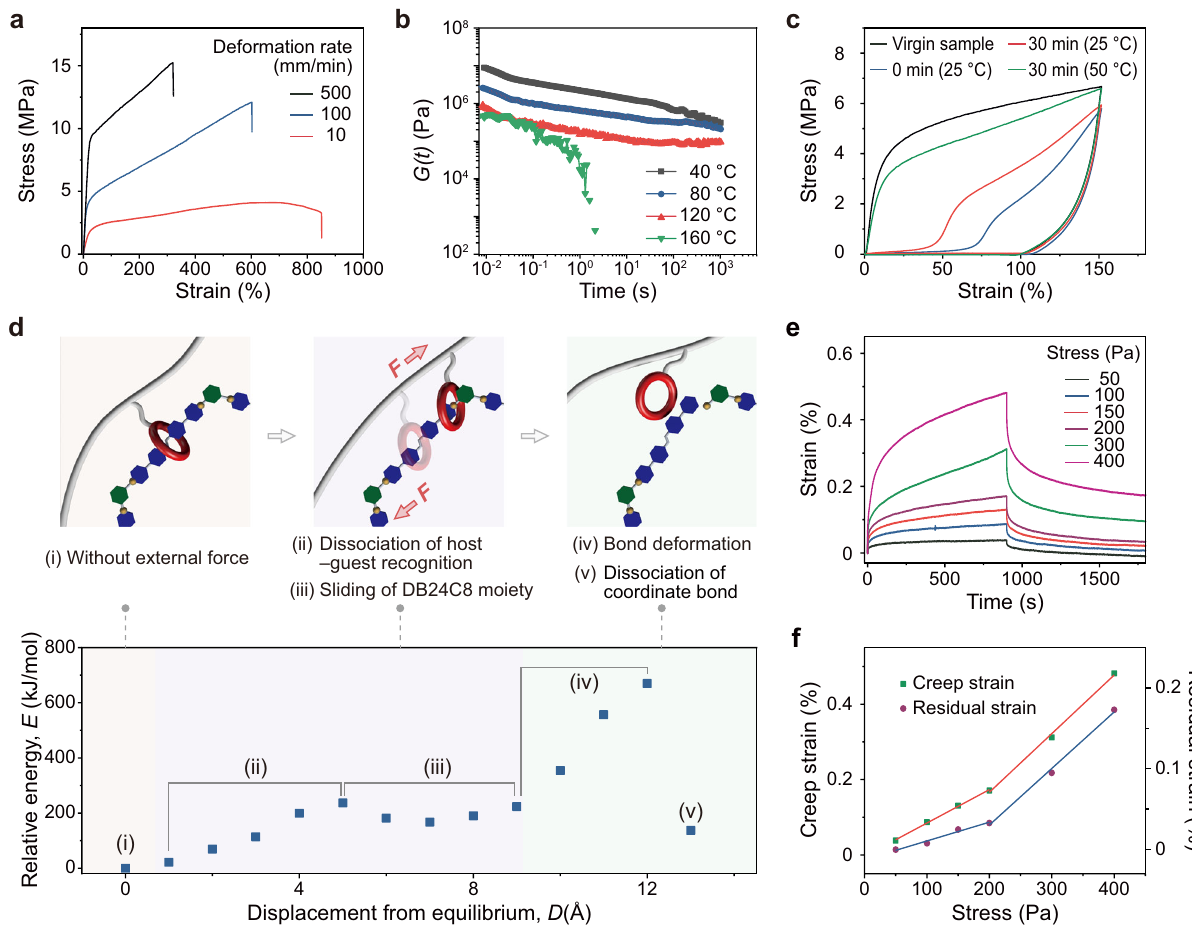
Fig. 5 Force-induced dynamicity of molecular necklace in MINs. a Tensile tests of MIN- 2 under different deformation rates ranging from 10 to 500mm/ min. b Temperature-dependent stress relaxation behaviors of MIN- 2 . c Cyclic tensile test curves of MIN- 2 loaded at a strain of 150% with different rest intervals and temperatures. d CoGEF potential as a function of stretched distance for a segment of a molecular necklace (bottom), and corresponding schematic representation of the force-induced dynamicity (top). e Creep-recovery curves of MIN- 2 with different stress levels at 30°C. f Plots of creep and residual strains under different stress